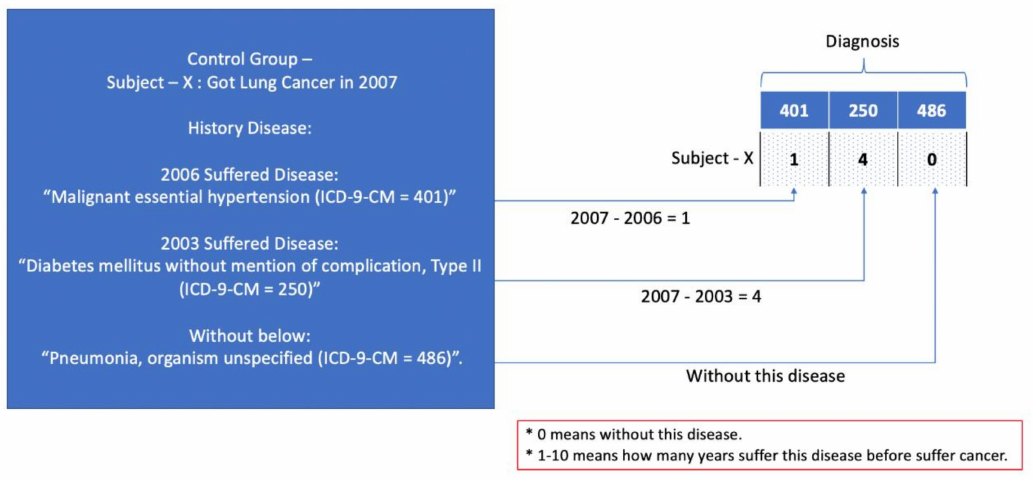
Figure 1. Data processing